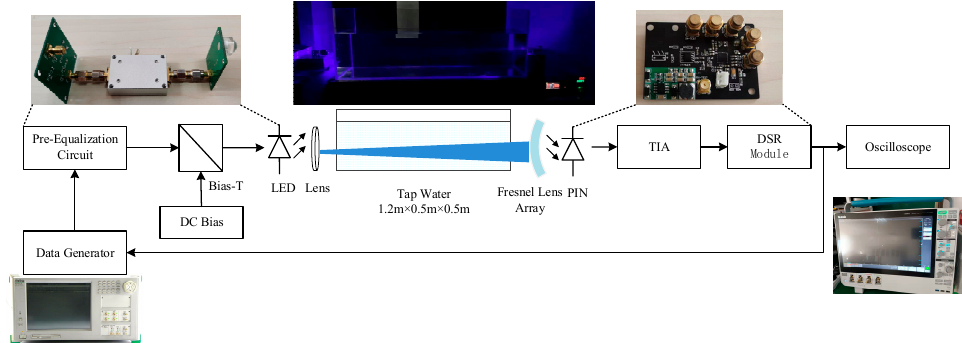
Figure 7. Experimental setup of the proposed MDOF UOWC system.